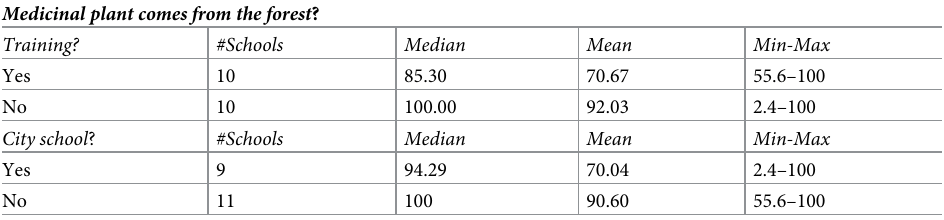
No significant differences were